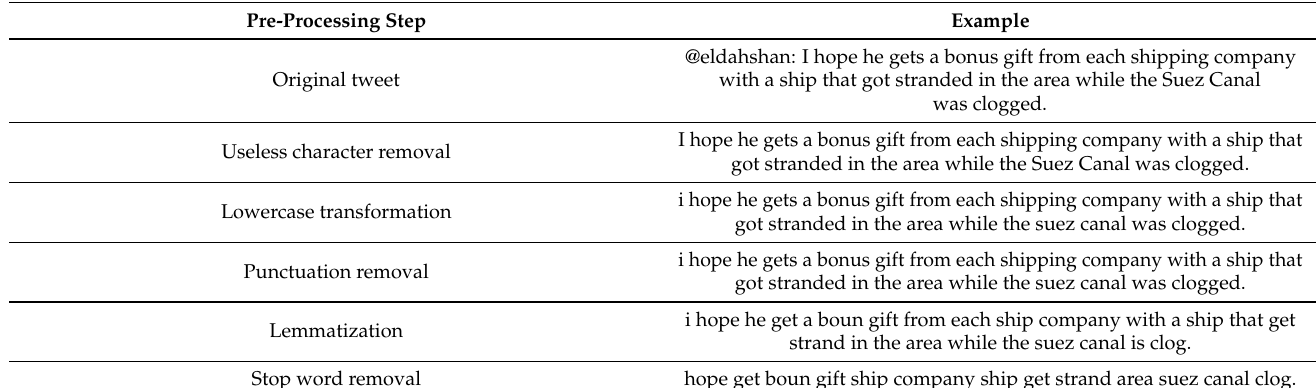
Table 1. Sample tweets after data preprocessing